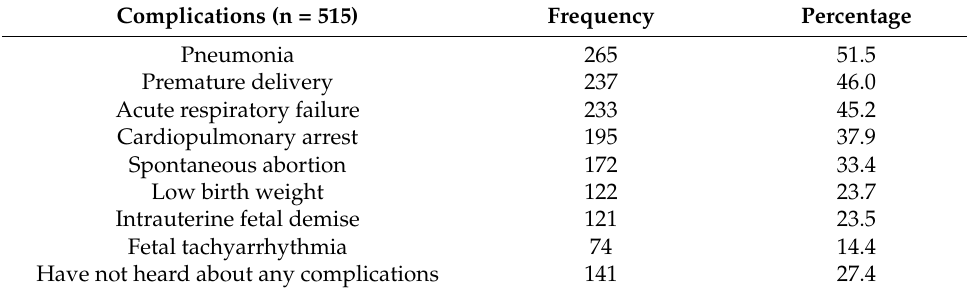
Table 7. Participants’ knowledge about the influenza complications in pregnancy.